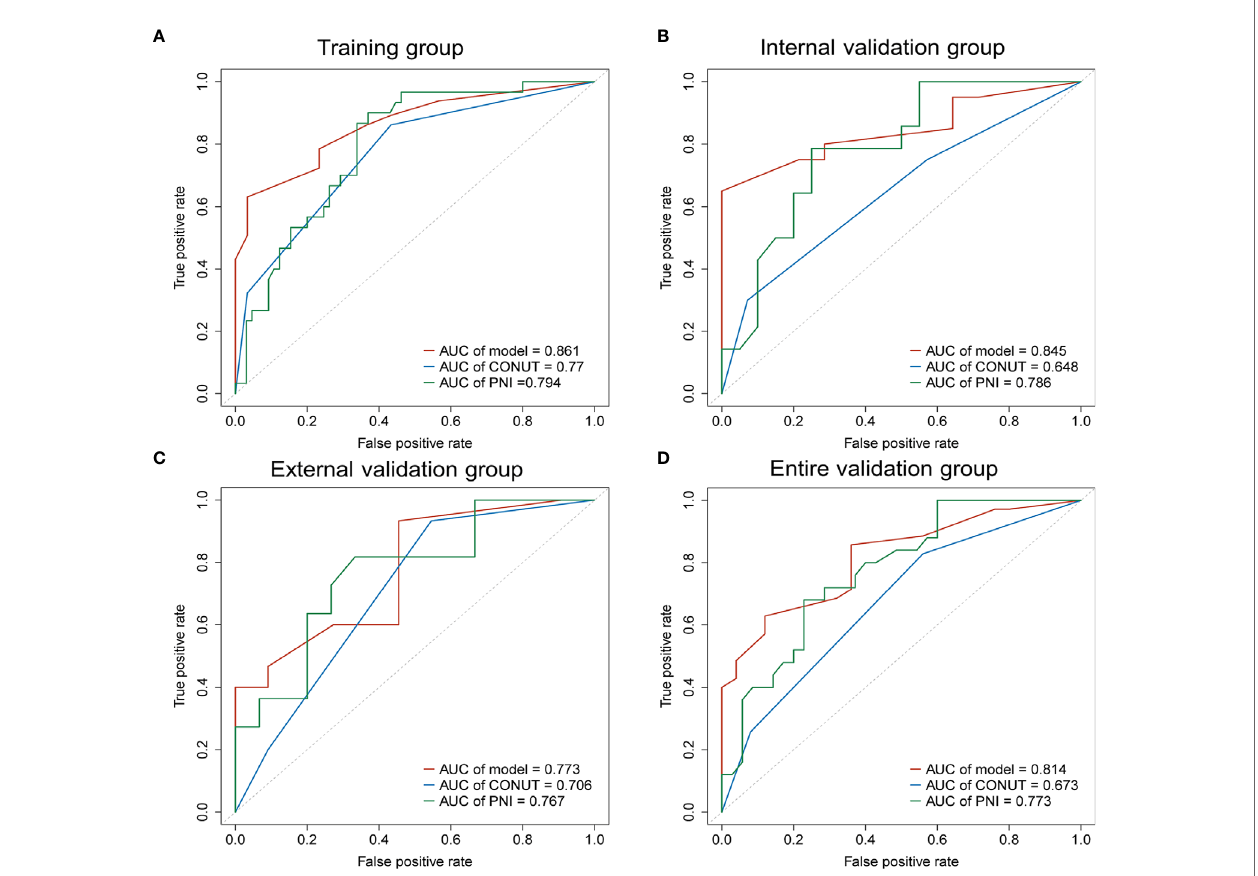
FIGURE 3 | Receiver operating characteristic curves (AUCs) of the nomogram, CONUT and PNI for predicting 2-year OS of patients with resected PDAC in the training, internal validation, external validation and entire validation groups. (A) AUCs in the training group; (B) AUCs in the internal validation group; (C) AUCs in the external validation group; (D) AUCs in the entire validation group.